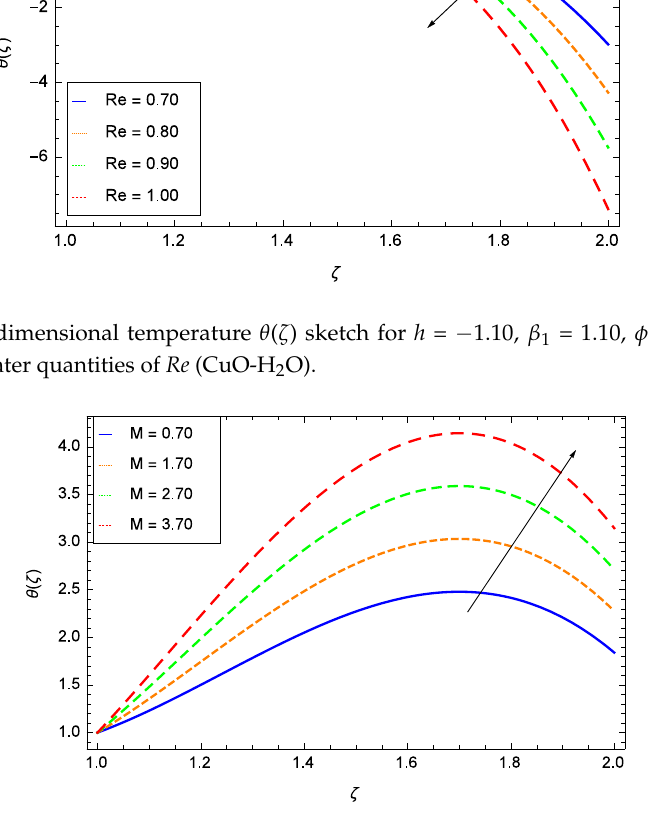
Figure 11. Non-dimensional temperature θ ( ζ ) sketch for h = − 2.50, β 1 = 1.70, φ = 0.04, M = 0.10, Pr = 6.80 and greater quantities of M (CuO-H 2